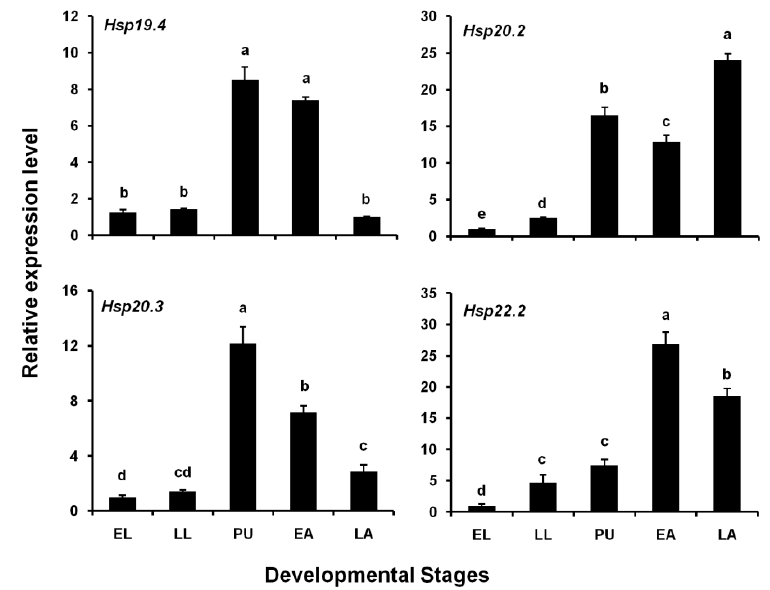
Figure 3. Relative expression levels of four LsHsp genes at different developmental stages of L. serricorne . EL, early larvae; LL, late larvae; PU, pupae; EA, early adults; LA, late adults. Different letters above bars indicate a significant difference among developmental stages based on one-way ANOVA followed by a least significant difference test ( p < 0.05).